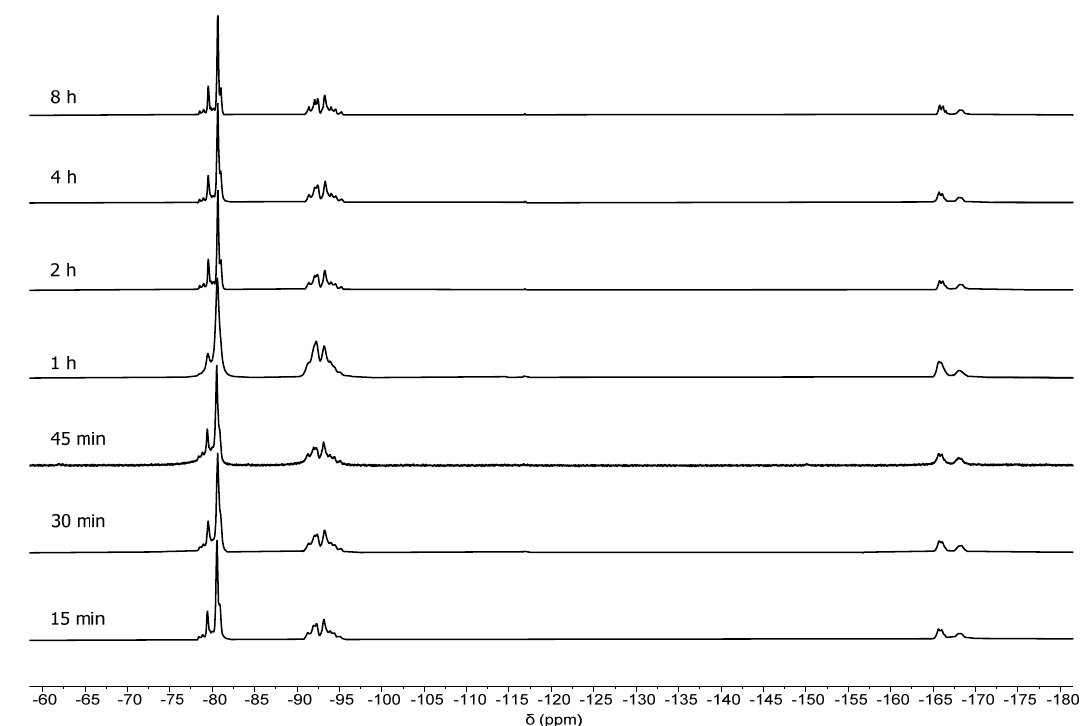
Figure 1. Stack of 19 F NMR spectra recorded at 25 °C in (CD 3 ) 2 CO of P(VDF- co -1234yf) copolymers at different polymerization times.